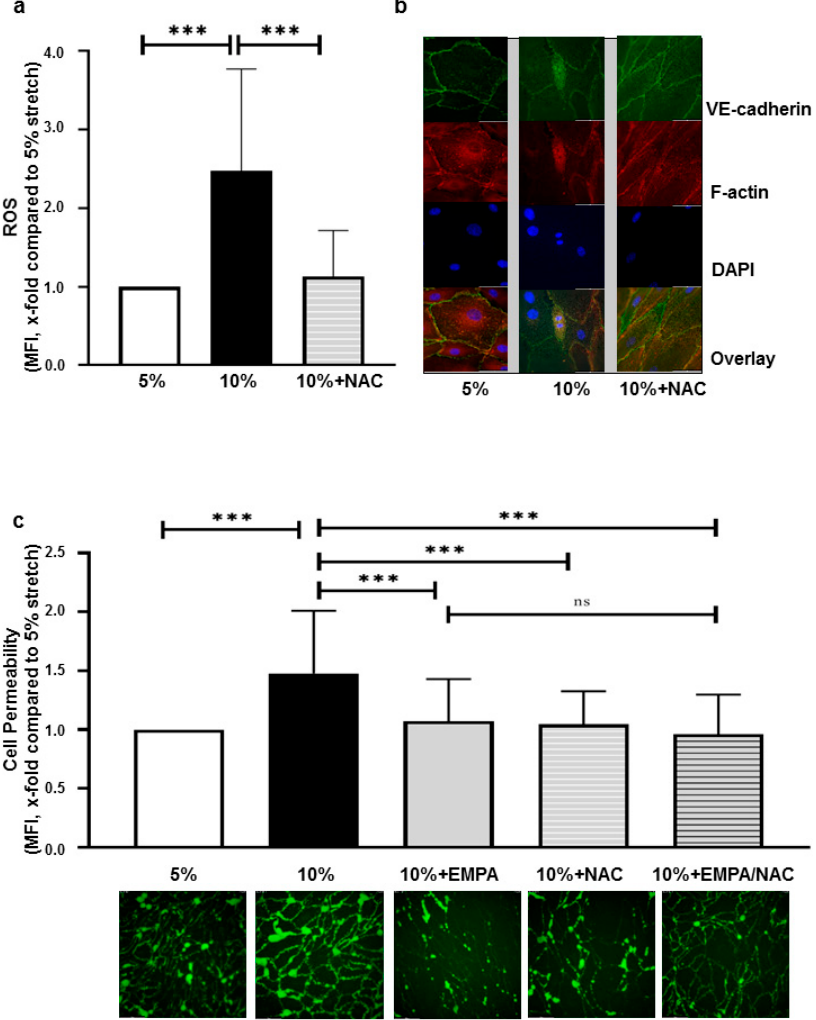
Figure 3. Alleviated stretch induced barrier dysfunction by EMPA might be mediated through ROS inhibition. ROS measurement and immunofluorescence staining were carried out in cells treated with 5% stretch plus vehicle, 10% stretch plus either vehicle or 5 mM NAC. After 24 h, 6 images per condition were taken from each individual experiment for ROS measurement ( a ) n = 5 individual experiments. Representative images of VE-cadherin and F-actin staining are presented in ( b ) (n = 3). Cell permeability was measured in cells treated with 5% stretch plus vehicle, 10% stretch plus vehicle, 1 µ M EMPA, 5 mM NAC or combination of EMPA and NAC. Six images per condition were taken from each individual experiment ( c , n = 5 individual experiments). Representative images of ROS and cell permeability are shown in the lower panel of each bar graph ( a , c ) and data are presented as mean ± SD. *** p < 0.001 vs. 10% stretch. ns: not significant. 2.4. ROS Inhibition of EMPA Might Partly Be Mediated through Inhibiting NHE1 and NOXs Cariporide (10 µ M) significantly reduced ROS production of cells undergoing 10% stretch (x-fold compared to 5% stretch, cariporide: 1.32 ± 0.89 vs. 10% stretch: 2.48 ± 1.30, p < 0.001). The combination of cariporide with EMPA did not further reduce ROS produc- tion (x-fold compared to 5% stretch, EMPA+cariporide: 1.47 ± 0.85 vs. EMPA, p >